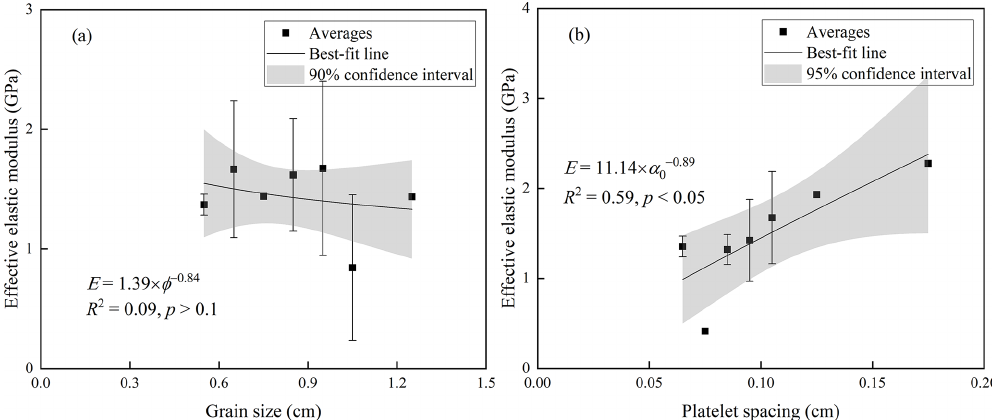
Figure 8. The variations of average effective elastic modulus with respect to (a) grain size and (b) platelet spacing for columnar ice. Also shown are the best-fit